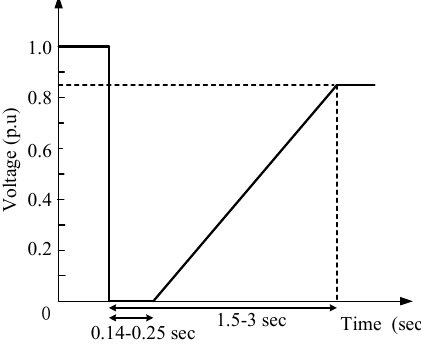
Figure 1. ENTSO ‐ E low ‐ voltage ride through (LVRT) requirement for grid